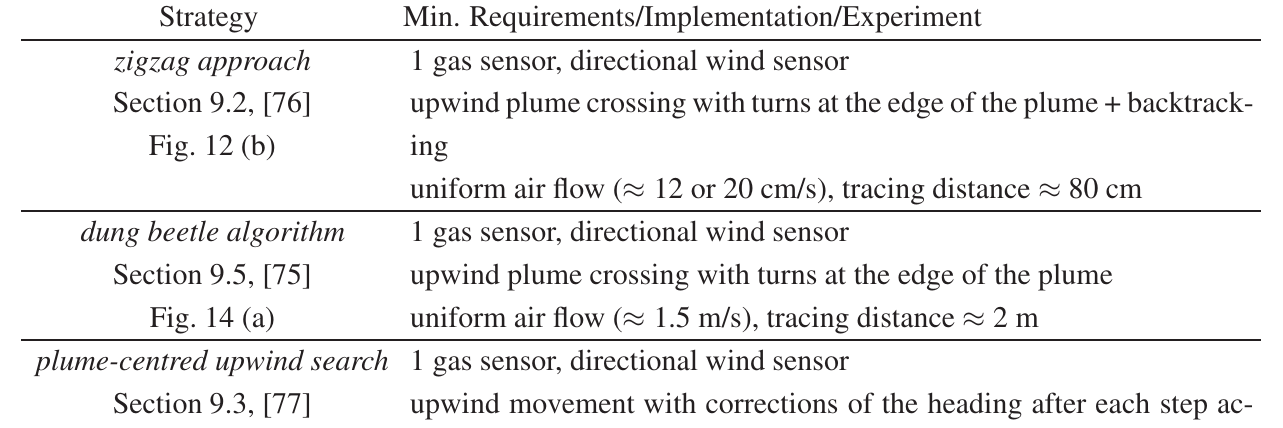
Table 1 . Gas source tracing strategies that were experimentally tested on a mobile robot and require information about the local wind